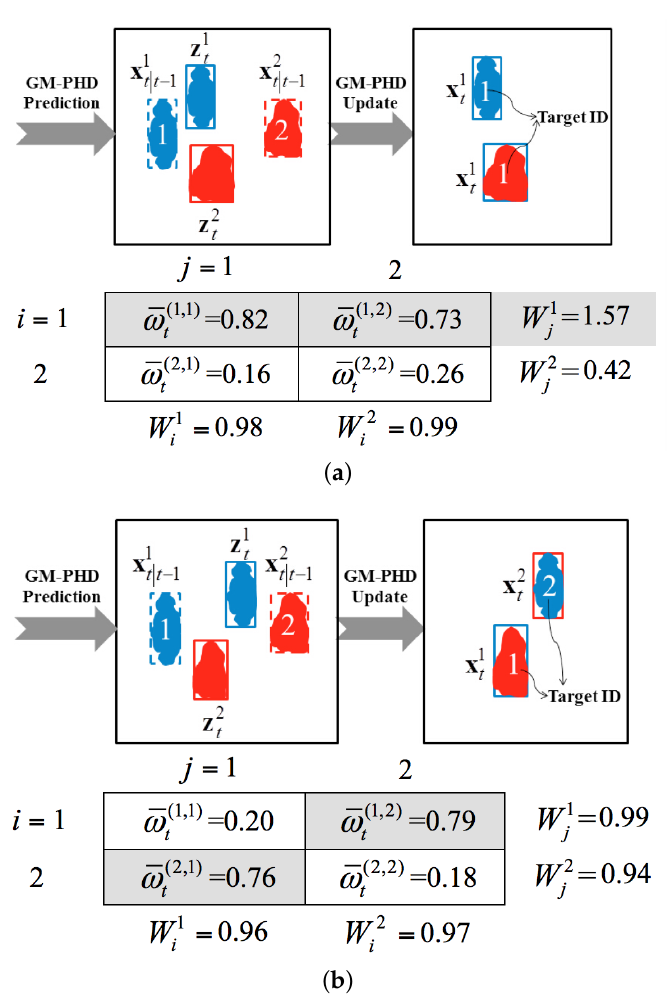
Figure 3. A pictorial example of tracking two targets in close movement. ( a ) Case 1: two targets with the same identity; ( b ) Case 2: two targets with switched